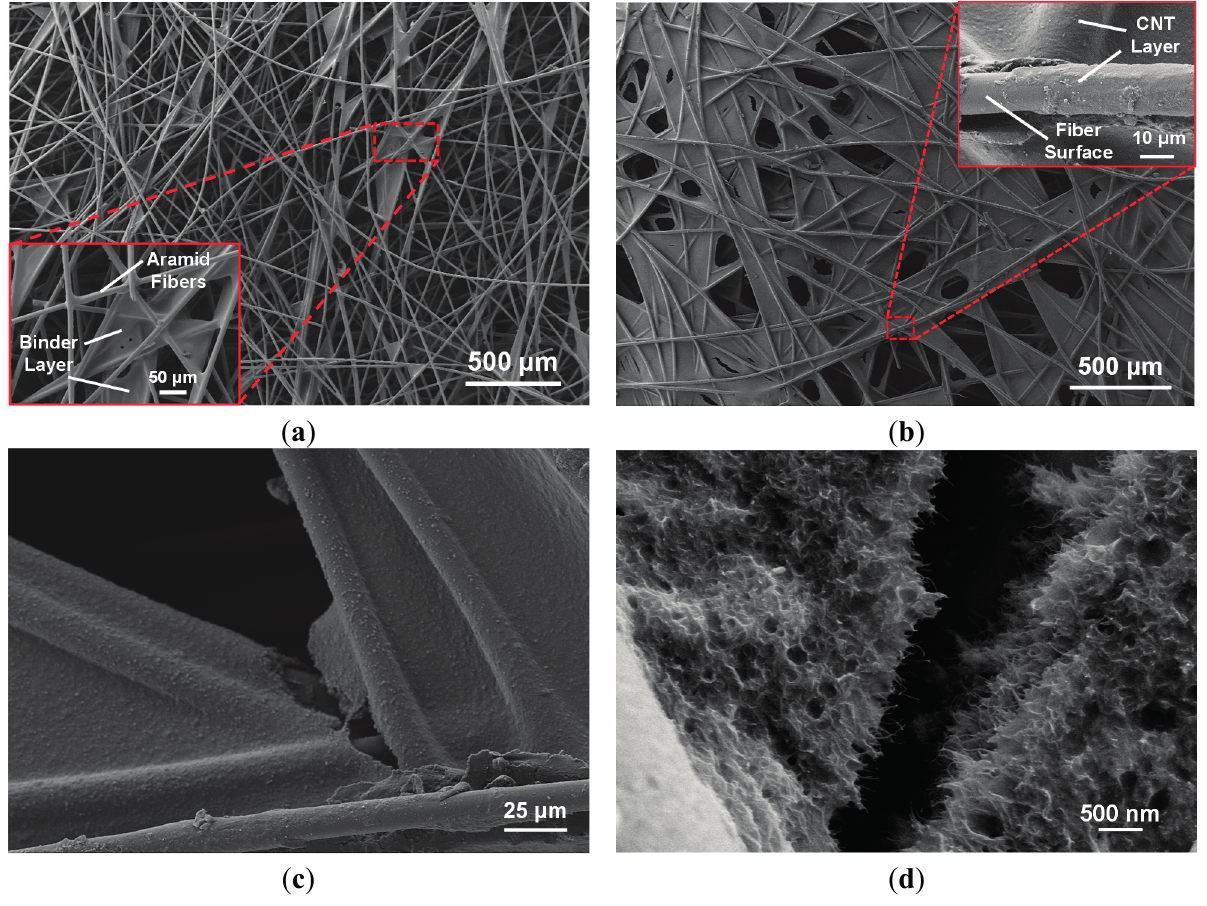
Figure 5. SEM micrographs showing ( a ) non-woven aramid fabric with binder (insert), ( b ) aramid fabric with CNTs deposited onto the fiber surface (inset), ( c ) fiber cross-over region with nanotubes uniformly coating the binder and fibers with ( d ) a high-magnification image showing the CNT